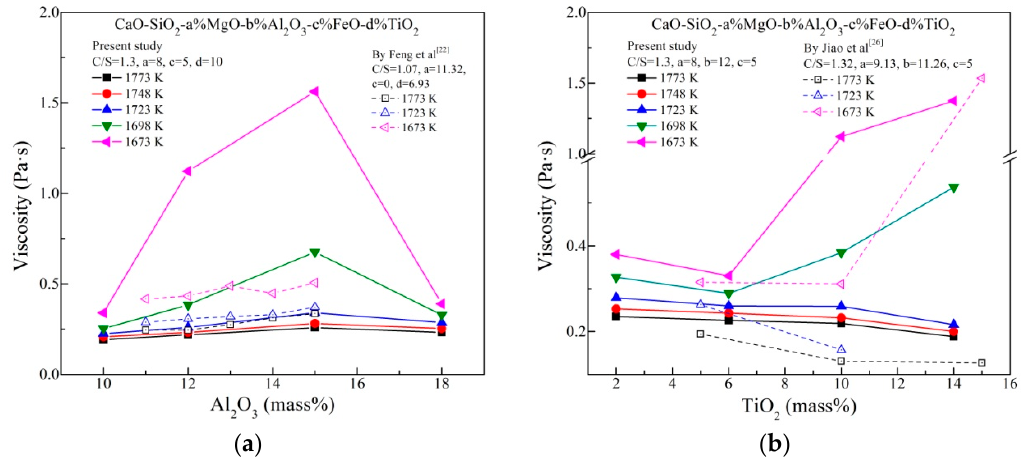
Figure 4. Effects of ( a ) Al 2 O 3 content and ( b ) TiO 2 content on viscosity at various temperatures. Figure 4. E ff ects of ( a ) Al 2 O 3 content and ( b ) TiO 2 content on viscosity at various